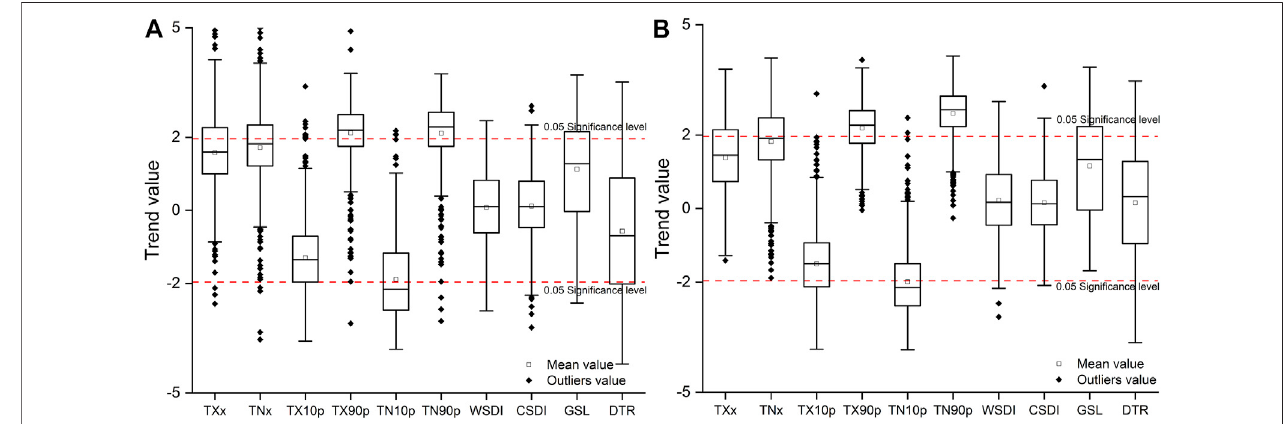
FIGURE 8 | Box plots of the PWMK test value of DISO for Obs (A) and ERA5 (B) for extreme temperature indices over China from 1979 to 2020.